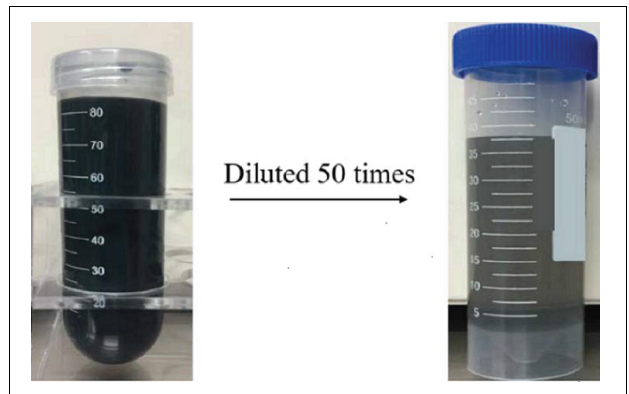
FIGURE 3 | Dilution of suspension for UV-vis spectra.